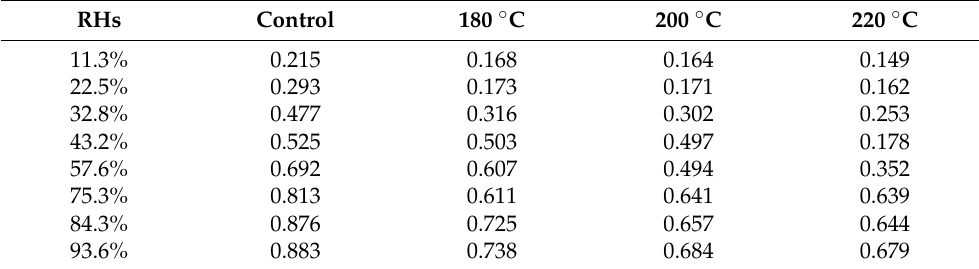
Figure 3. The T 2 relaxation time distribution of Douglas fir ( Pseudotsuga menziesii ) after conditions at various RHs. Table 3. The T 2 value of bound water peak after conditions at various RHs (unit: